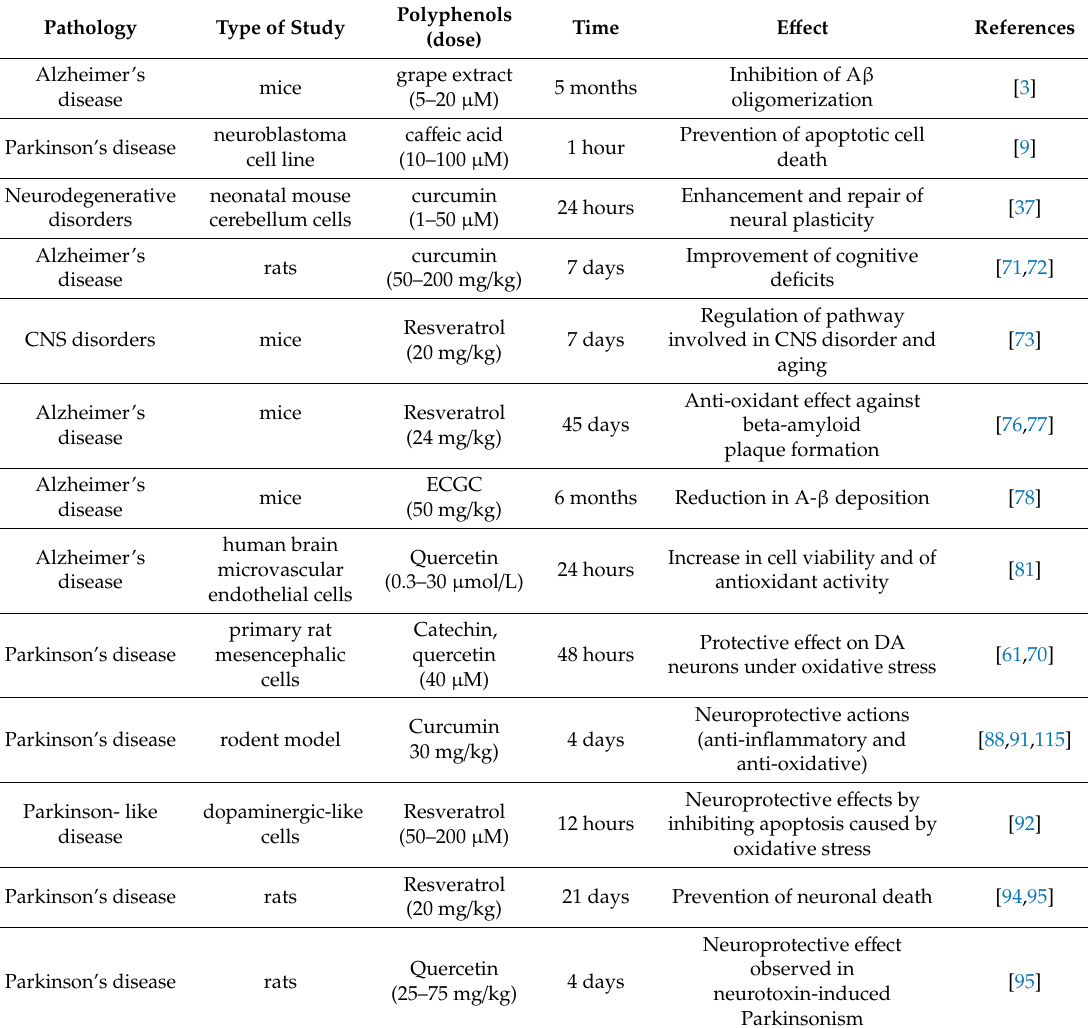
Table 2. Summary of the e ff ects of polyphenol treatment from in vitro and in vivo